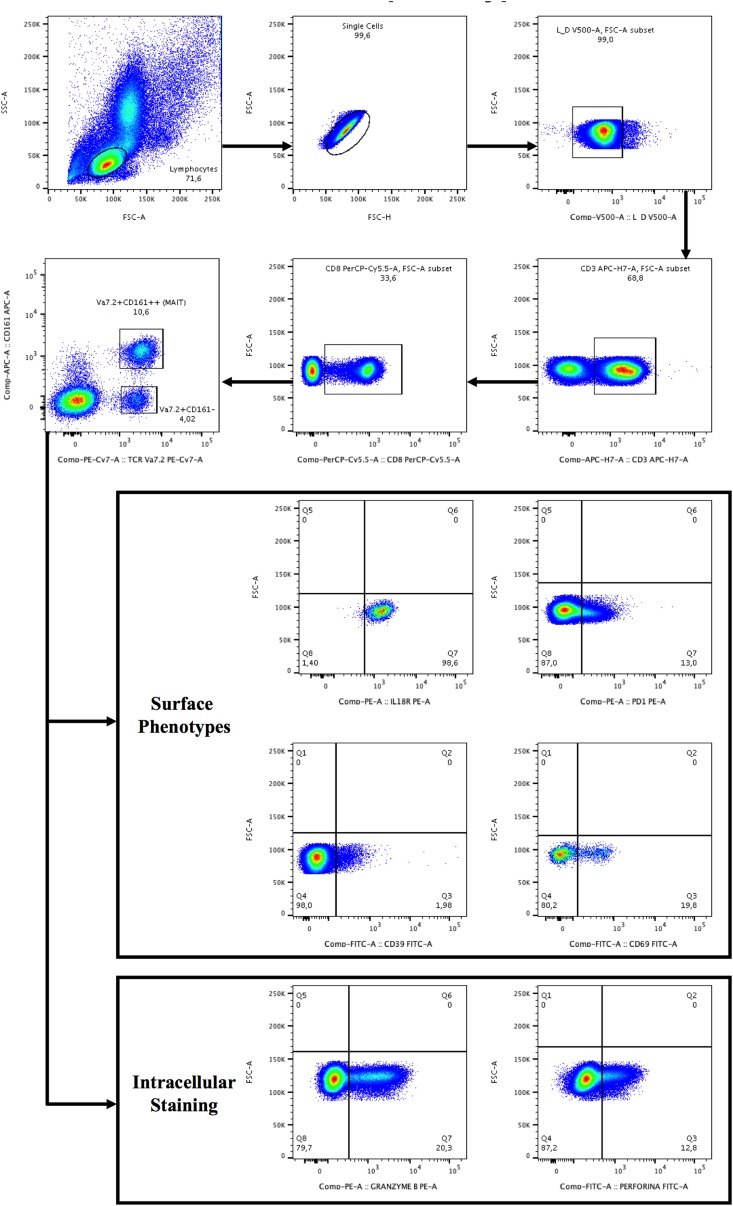
Gating strategy for the identification of Vα7.2+CD161++CD8+ and Vα7.2+CD161-CD8+ T-cell subset and surface/intracellular phenotypes. Lymphocytes were gated from forward (FSC) and side scatters (SSC), doublets were removed and live cells were selected, segregated for CD3+ T-cells and subsequently for CD8+ T-cells. CD8+ T+cells were categorized as CD161- or CD161++ (bright), followed by the selection of TCR Vα7.2. The gates were set up based on positive versus negative peak. Depicted are representative plots from representative subject PBMCs.